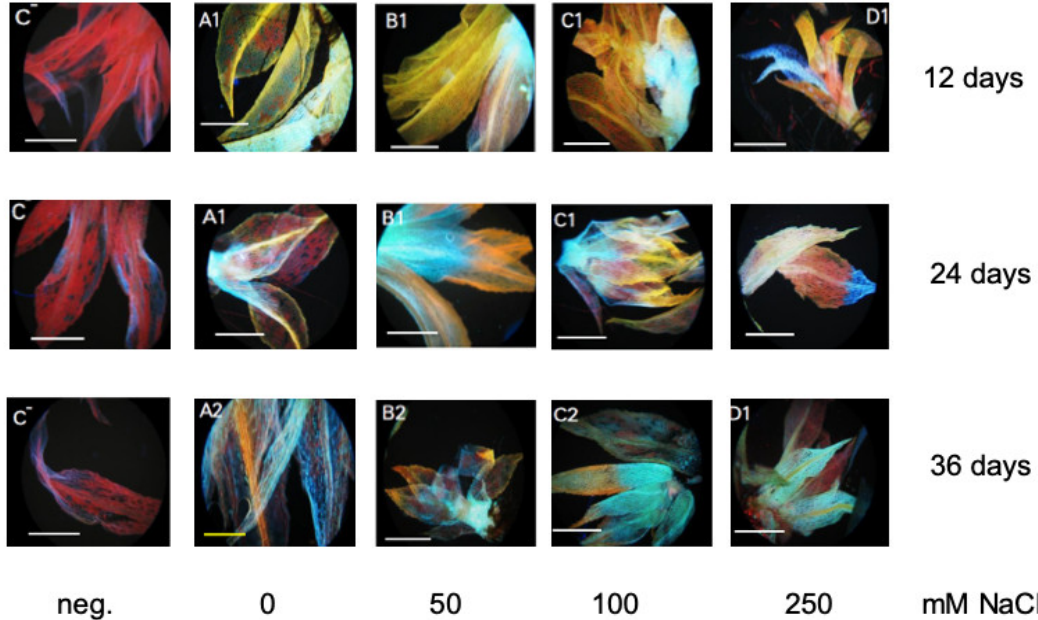
Figure 7. In situ staining of flavonoids with DPBA according to the method of Buer and Muday [53]. Individual gametophores are shown for the different salt concentrations at three different time points. The first panel is the negative (neg.) control without DPBA (C − ); mainly showing the red autofluorescence of chlorophyll. Yellow color denotes quercetin derivatives, cyan naringenin derivatives, and green kaempferol derivatives, while blue denotes sinapate derivatives. The negative controls without staining solution show only the red chlorophyll fluorescence. Only one set of pictures for WT is shown for all three time points. All data including two mutant lines are shown in the Supplementary Materials (Figure S6). The bars indicate 100 µm.